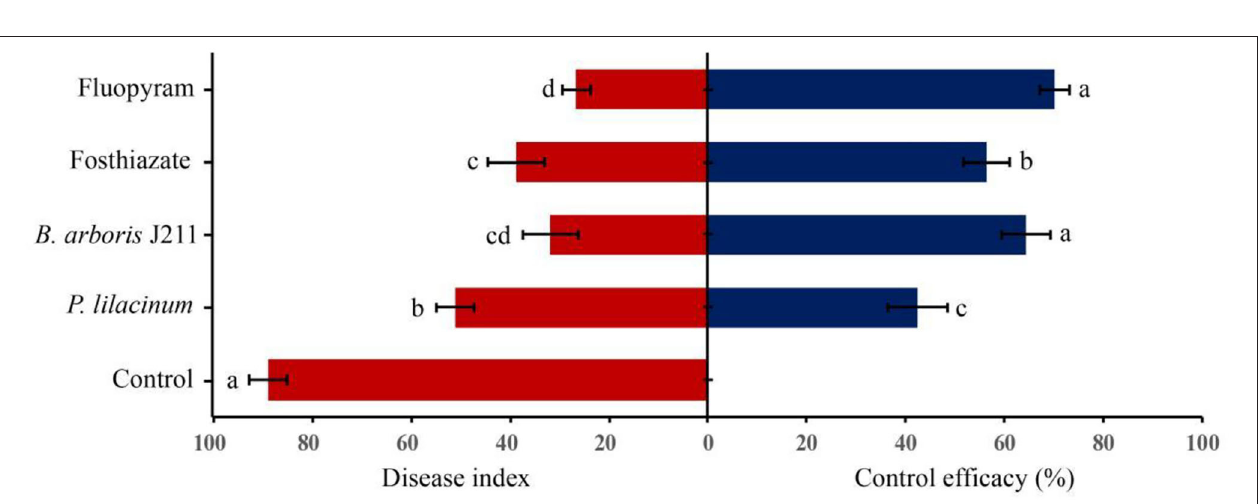
FIGURE 4 | Effect of chemical and biological nematicides against tobacco RKNs in the field. Bars represent the mean ± standard deviation of three replicates (10 tobacco plants per replicate). Bars with the same letters are not significantly different ( P > 0.05) based on Duncan’s multiple-range tests.